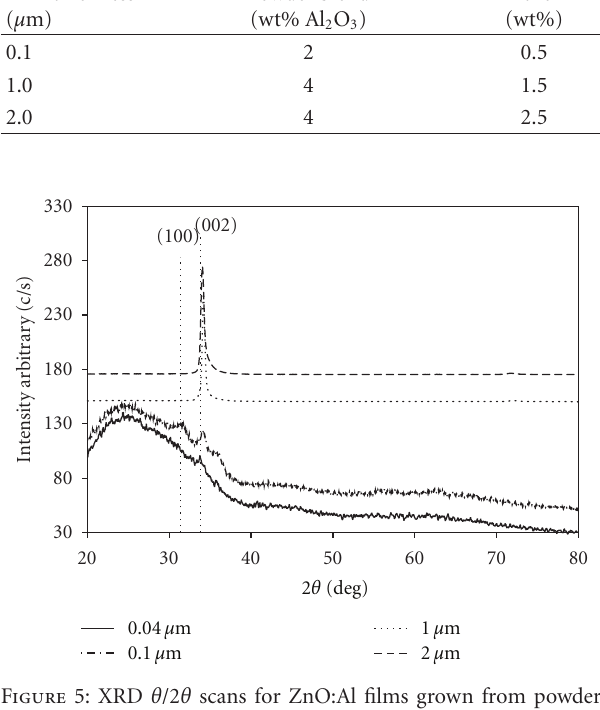
Figure 6: Calculated grain size for the ZnO:Al films grown from powder